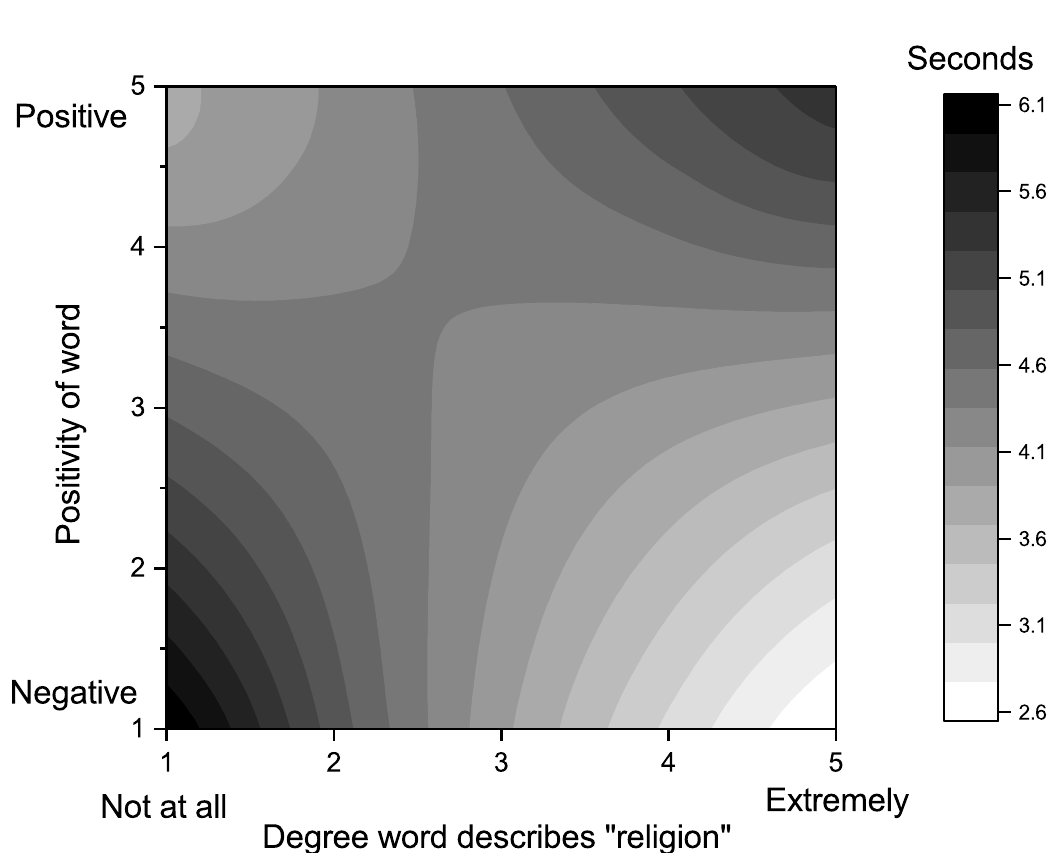
Figure 4: Raters: atheists; target: religion; predicted response latency